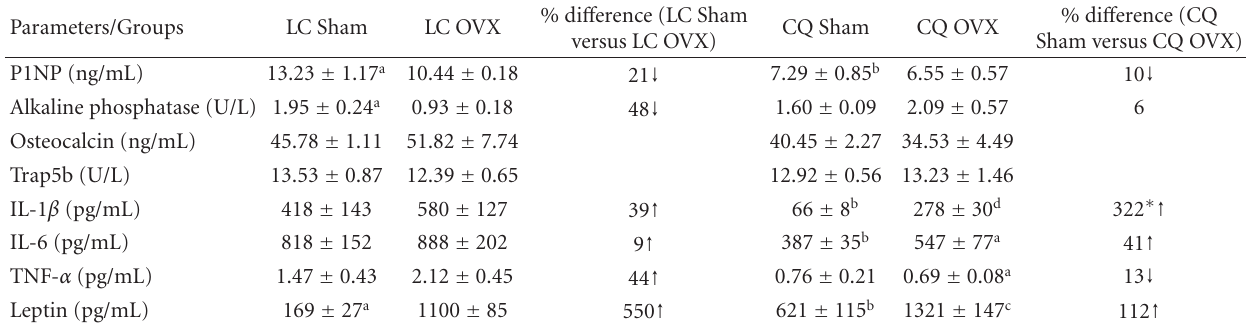
Table 2: E ff ects of Cissus quadrangularis on the Biochemical markers of bone turnover, pro-inflammatory cytokines and leptin in the serum of female ovariectomized C57BL/6